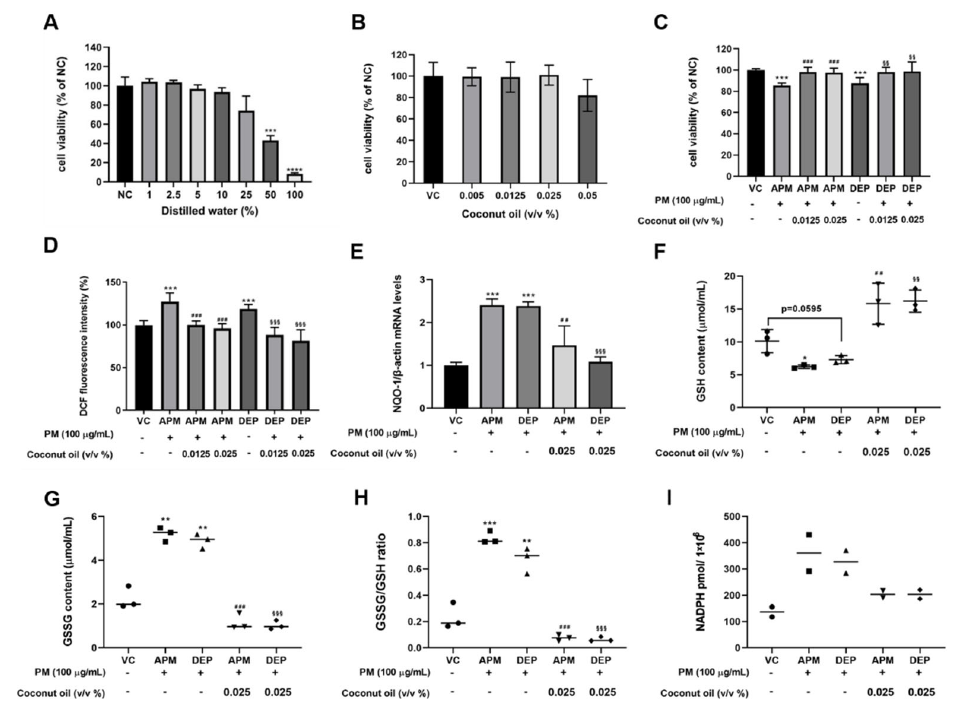
Figure 3. Effects of coconut oil on oxidative stress in artificial particulate matter (APM) and diesel exhaust particles (DEP) − stimulated alveolar macrophages (MH − S). ( A , B ) Cytotoxicity assessment of distilled water (DW) and coconut oil via the 3–(4,5–dimethylthiazol–2–yl)–2,5–diphenyltetrazolium bromide (MTT) assay. ( C ) Cytotoxicity assessment of coconut oil in APM and DEP − stimulated MH − S. ( D ) Reactive oxygen species ( ROS) production was measured using 2 ′ ,7 ′− dichlorofluorescein diacetate (DCF − DA) staining. Data represent the mean ± SD (n = 8 per group). ( E ) NADPH dehydrogenase (quinone) ( NQO1 ) gene level was measured using real − time PCR. ( F ) Glutathione (GSH), ( G ) glutathione disulfide (GSSG), ( H ) GSSG/GSH ratio, and ( I ) Nicotinamide adenine dinucleotide phosphate (NADPH) levels in MH − S. Negative controls (NC) are untreated samples. Vehicle control (VC) was treated with cell medium including 10% DW. Data are presented as the means ± SD of three independent experiments. * p < 0.05, ** p < 0.01 or *** p < 0.001, **** p < 0.0001 vs. NC or VC; ## p < 0.01 or ### p < 0.001 vs. APM group; §§ p < 0.01 or §§§ p < 0.001 vs. DEP